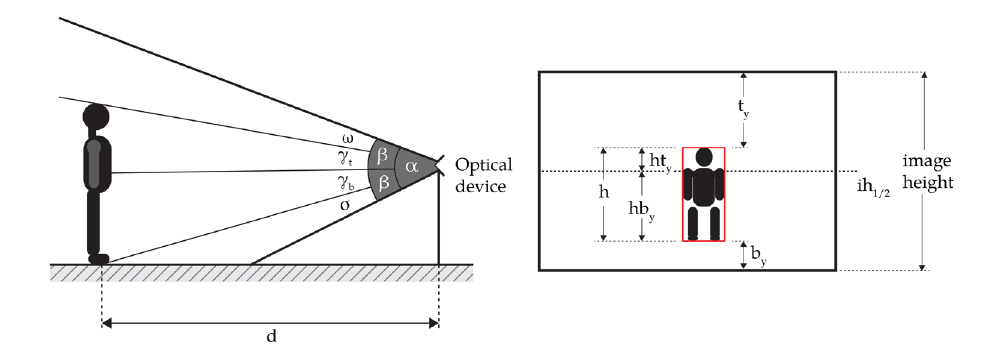
Figure 2. Calculated angles and distances in the image